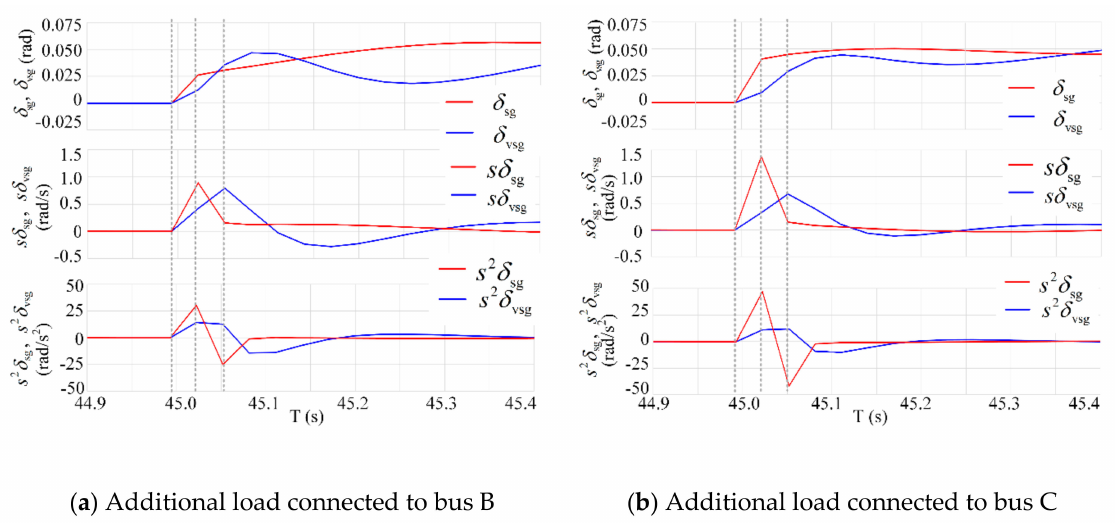
Figure 5. Transient responses of phase differences: δ sg and δ vsg are the phase differences of the SG and VSG, respectively; s δ sg and s δ vsg are respectively the first derivatives of δ sg and δ vsg ; and s 2 δ sg and s 2 δ vsg are respectively the second derivatives of δ sg and δ vsg